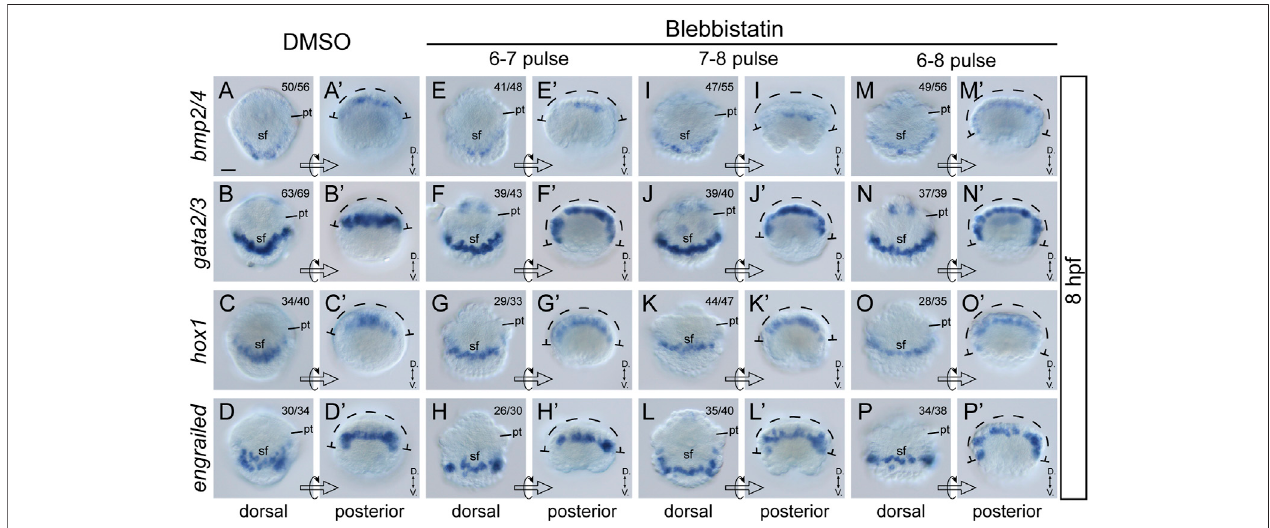
FIGURE 6 | Expression of four pSF genes at 8 hpf after blebbistatin treatments. Panels (A – P) show dorsal views, anterior to the top, and (A 9 – P 9 ) show posterior views dorsal to the top. The dashed curves in (A 9 – P 9 ) indicate the width of gene expression regions, which is generally spread in manipulated embryos. D., Dorsal. V., Ventral. pt, prototroch. sf, shell fi eld. The bar represents 25 μ